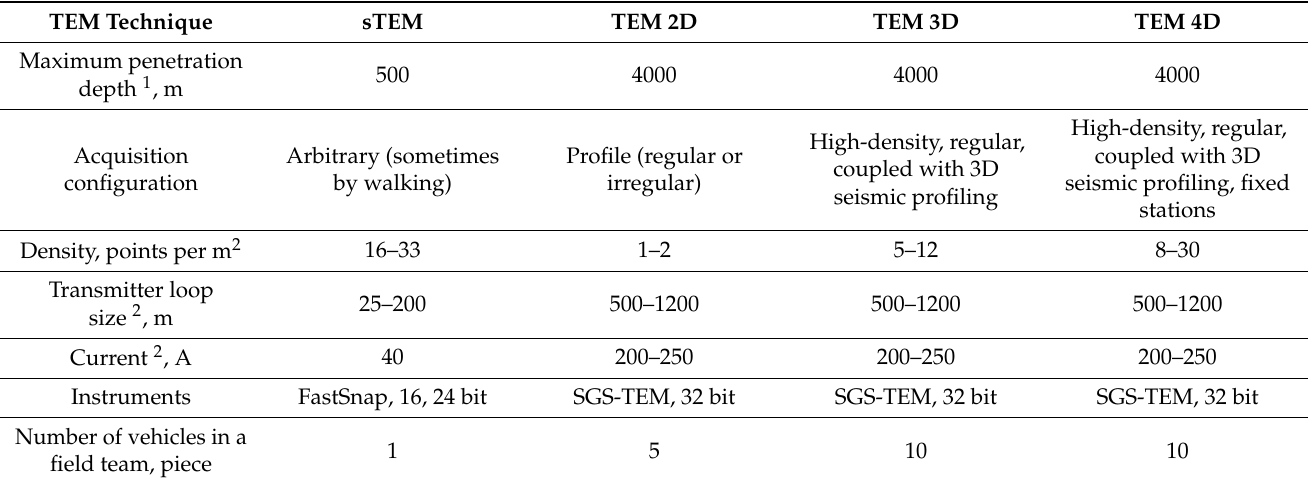
Table 1. Comparison of sTEM, 2D TEM, 3D TEM, and 4D TEM surveys. Adapted with